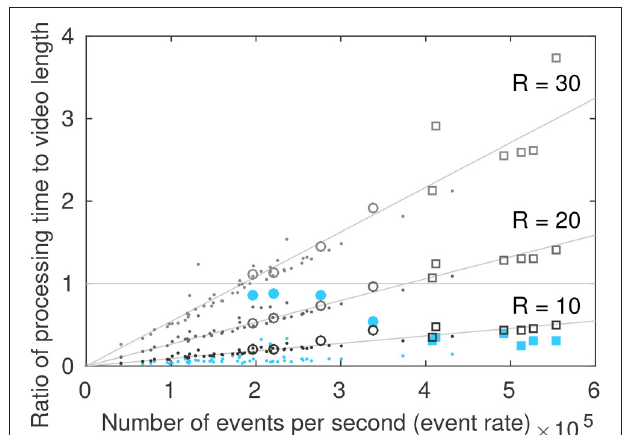
FIGURE 10 | Processing time as a function of the event rate. The area below the horizontal line represents real time processing. Squares represent segments of the “city” video, circles represent segments of the “tunnel” video, dots represent other indoor and outdoor scenes. Filled blue circles and squares represent global tone mapping, empty circles and squares represent the local tone mapping for different radius